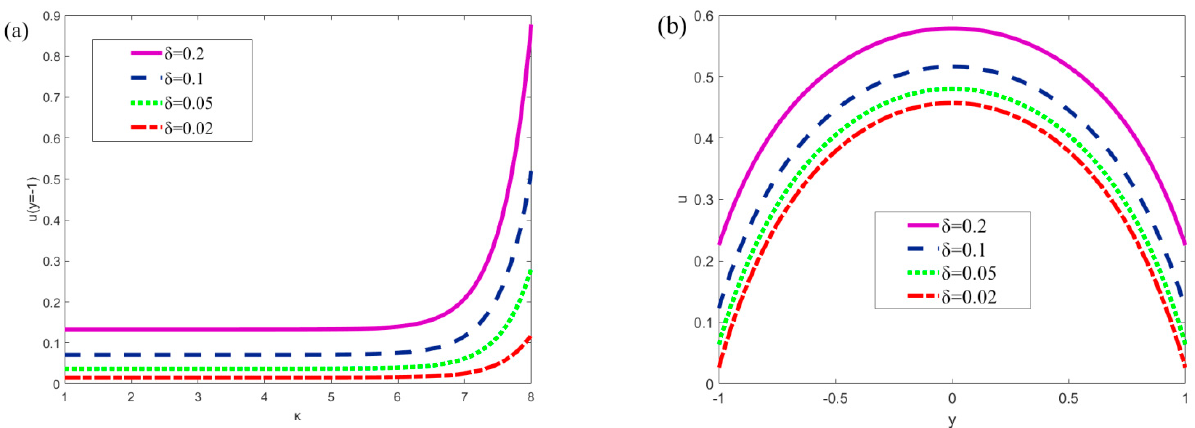
Figure 6. The variations of velocity with the nondimensional slip length δ ( x = π /2, m = 0.5, n = 0.8, Ha = 1, ξ 1 = 0.02, ξ 2 = 0.02, α = 5, β = 5, u r = 1, R = 1). ( a ) The variations in velocity at y = − 1; ( b ) Velocity variations in microchannel ( κ = 5).